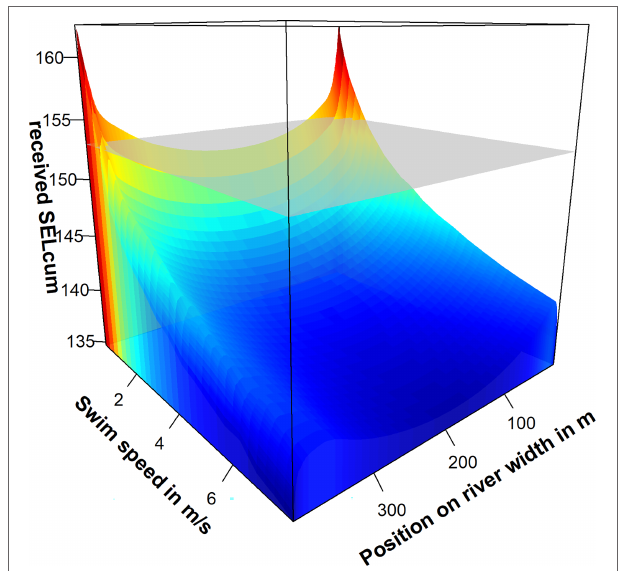
FIGURE 9 | Received cumulative sound exposure levels (SEL cum ) on simulated transects passing the acoustic flowmeters. The simulation was performed for a swim speed between 0.25 and 8 m s -1 ) and a continuous depth of 5 m. The received SEL cum (z-axis, color-coded) represents the cumulative SEL a harbor porpoise would receive, when passing the flowmeters and keeps a constant distance to the riverbanks. The grey grid represents the cumulative SEL-TTS onset suggested by Southall et al.